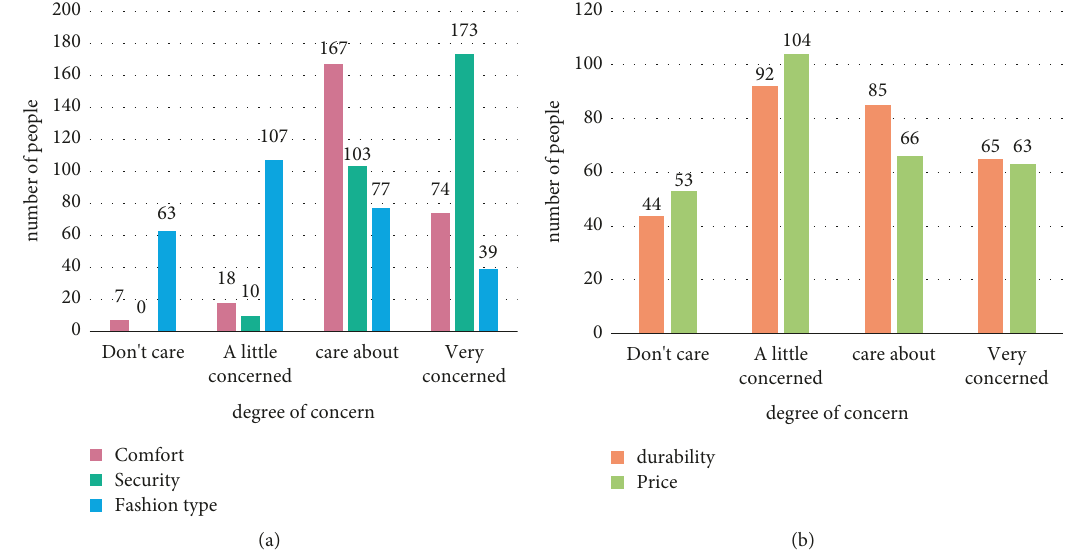
Figure 12: Statistics of the degree of attention to clothing